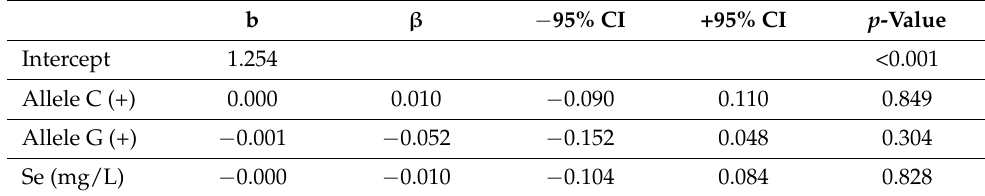
Table 5. Dependent variable: BMI (without moderation). b β − 95% CI